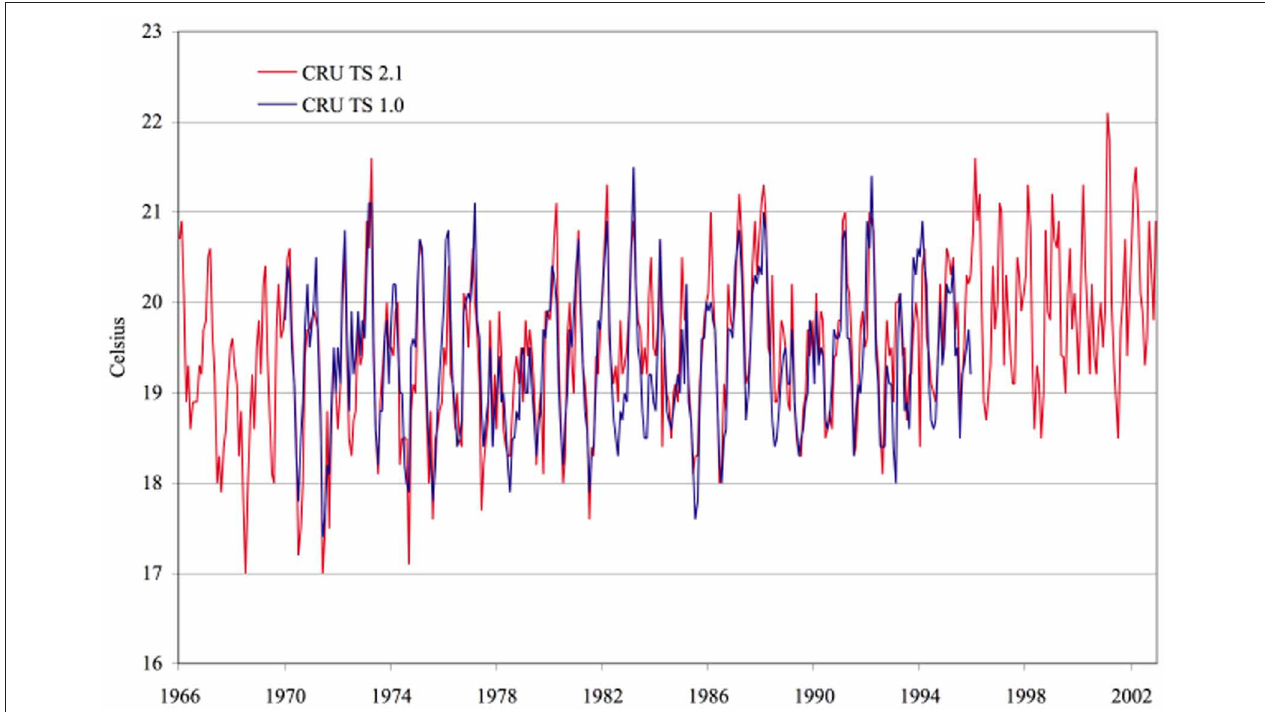
FIGURE 4 | Temperature series for Kericho: CRU TS 1.0 vs. CRU TS 2.1. Source: Stern et al. (2011), with permission from Dr. David I. Stern, Crawford School of Economics and Government, Australian National University.